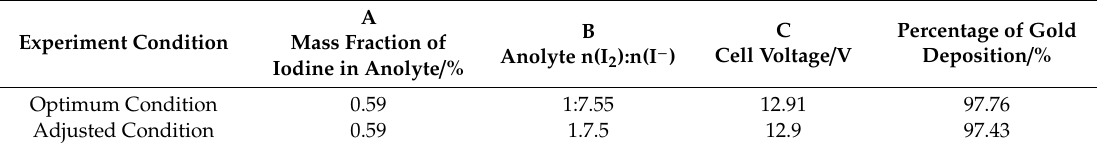
Table 4. Verification results of response surface optimization.